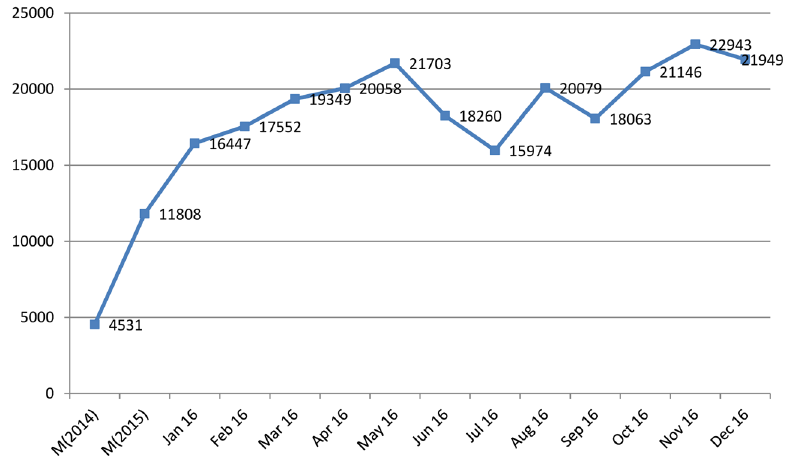
Figure 1. Number of article downloads per month in 2016.